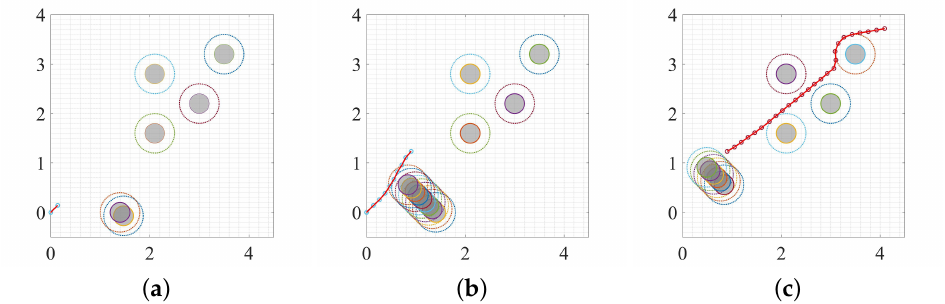
Figure 14. The robot uses the DIAPF approach to avoid a fast moving obstacle in the dynamic environment: ( a ) before avoiding; ( b ) avoiding the dynamic obstacle; and ( c ) finish avoiding.